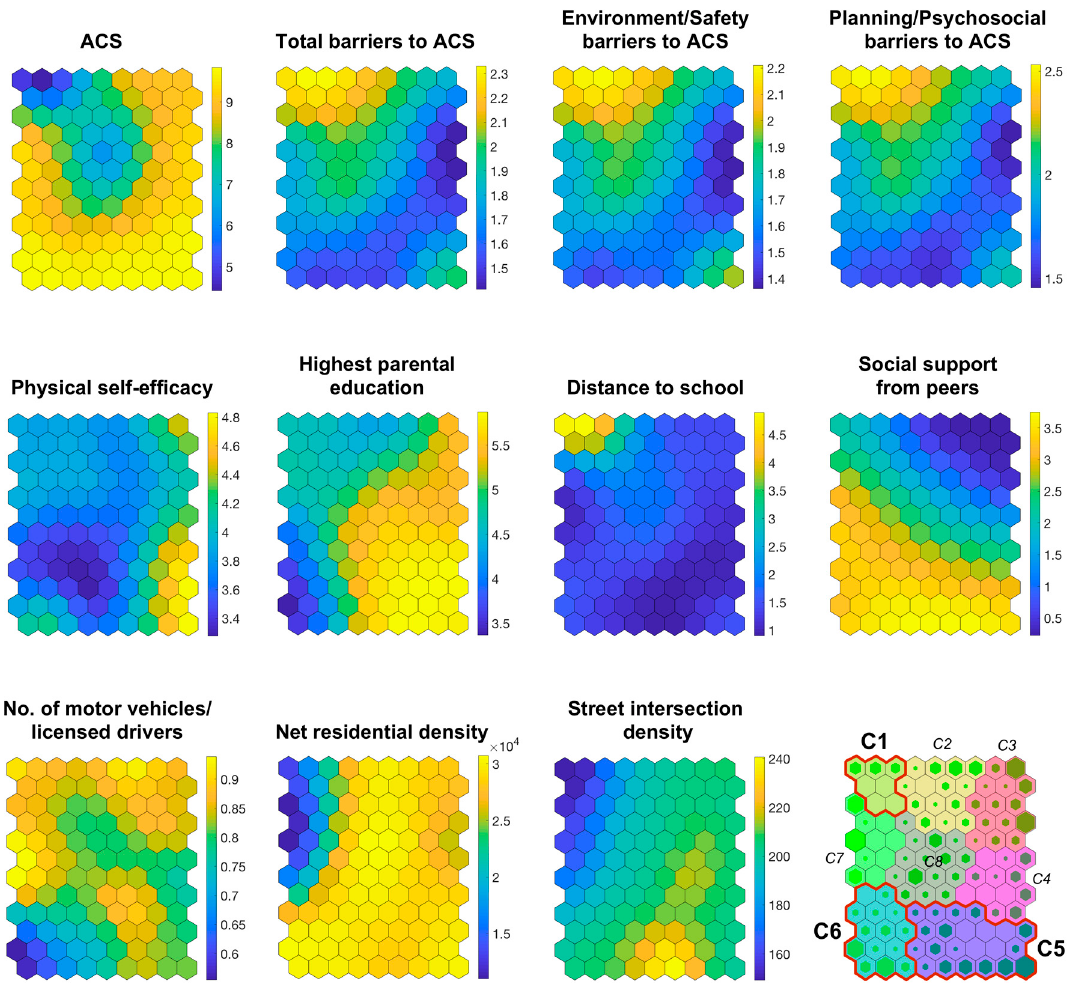
Figure 1. Component planes, clusters and hits obtained by the Self-Organizing Maps approach. Hits map can be seen in the right bottom corner. Empty cells show a lack of cases and greener cells indicate a large number of adolescents accumulated in them. In this map, each cluster is represented with one color and number. The eleven variables included in the analysis appear from the top to the bottom rows and from the left to the right columns. Rectangles on the right of each component map indicate the lower (blue/black) and higher (yellow/white) values of each variable. In order to understand the maps it is important to note that participants included in each neuron (hexagon) are the same in every component plane. ACS = active commuting to and from school.